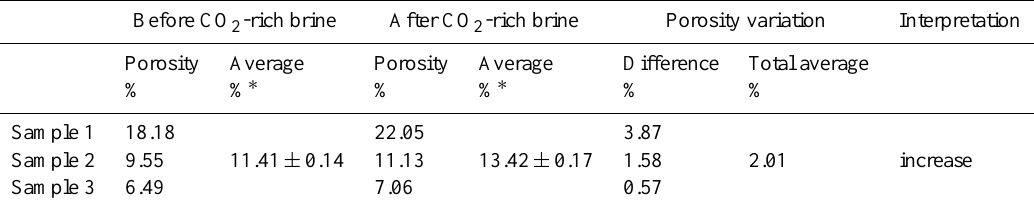
Table 1. Total porosity of Utrillas sandstones (three samples), before and after SC CO 2 -brine exposure, measured by optical image analysis (OIA). Average % is the average porosity of the three samples. Before CO 2 -rich brine After CO 2 -rich brine Porosity variation Interpretation Porosity Average Porosity Average Difference Total average % % ∗ % % ∗ % % Sample 1 18.18 22.05 Sample